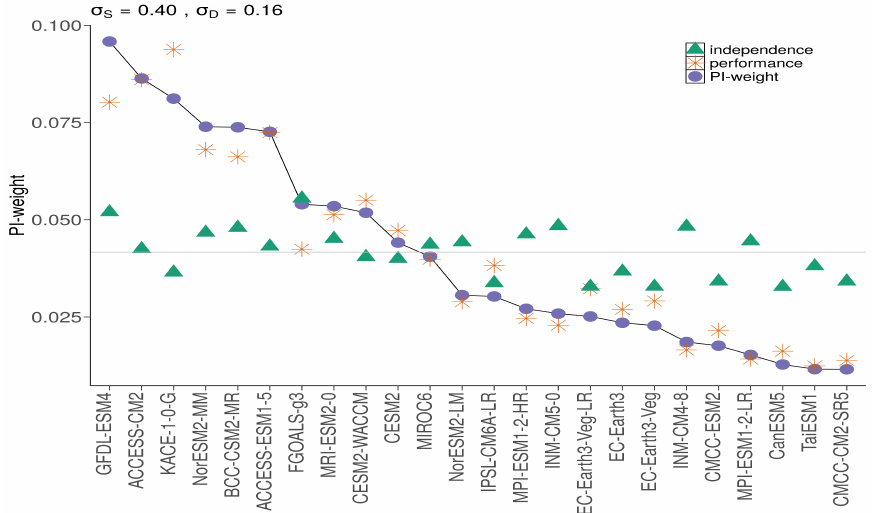
Figure 3. Distribution of the weights for the 24 CMIP6 models calculated based on the performance only (asterisk), the independence only (triangle), and both the performance and independence (circle). The weights are computed from the five climate variables for the Middle